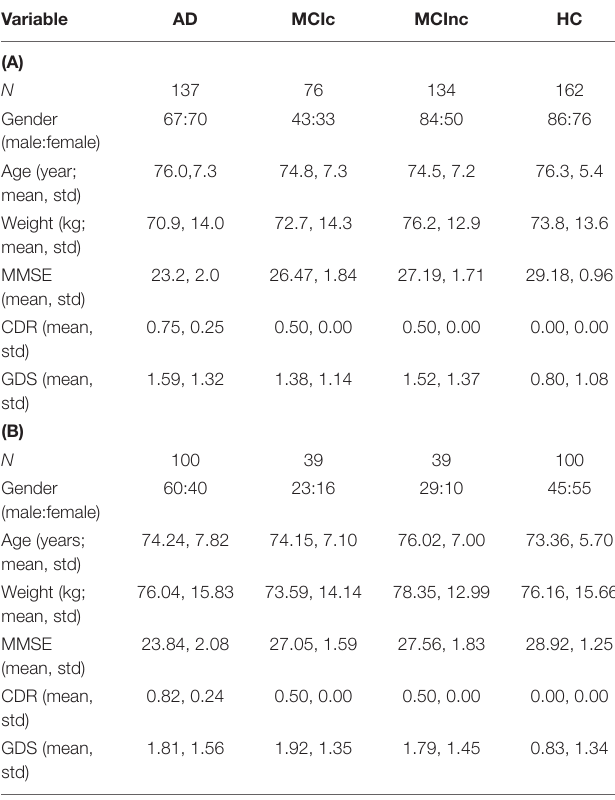
TABLE 1 | Characteristics of participants in (A) the training and testing dataset (upper panel) and (B) the validation dataset (lower panel). Variable AD